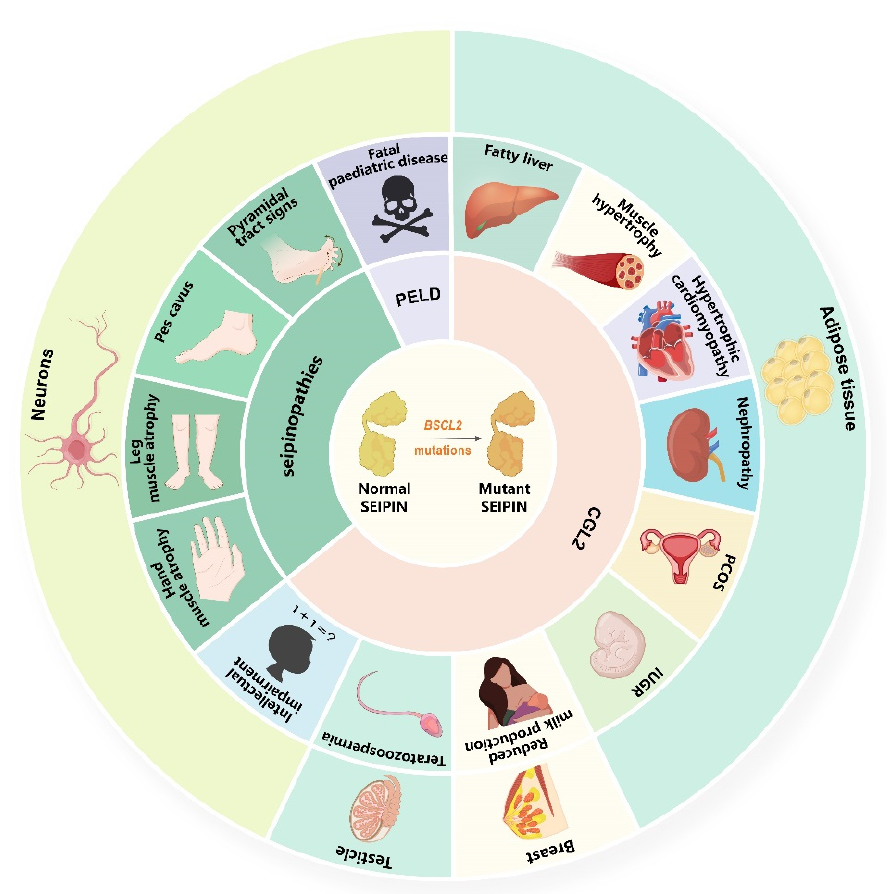
Figure 1. Clinical features and organs damaged in diseases caused by BSCL2 mutations. BSCL2 mutations produce mutant seipin, and mutant seipin induces CGL2, PELD, and BSCL2 -associated motor neuron diseases. CGL2 is characterised by metabolic disorders and its complications, which may be caused by adipose tissue loss. In addition, phenotypes resulting from seipin deficiency in breast, testicles, and neurons, including reduced milk production, teratozoospermia, and intellectual impairment, are also observed in CGL2. PELD is a fatal paediatric neurodegenerative disease. BSCL2 -associated motor neuron diseases are predominantly damaging motor neurons, resulting in weakness and atrophy of distal muscle groups (hands and legs), foot deformity (pes cavus), and pyramidal tract signs. Abbreviations: BSCL2 : Berardinelli ‐ Seip congenital lipodystrophy type 2; CGL2: type 2 congenital generalised lipodystrophy; PELD: progressive encephalopathy with or without lipodystrophy; PCOS: polycystic ovary syndrome; IUGR: intrauterine growth restriction.